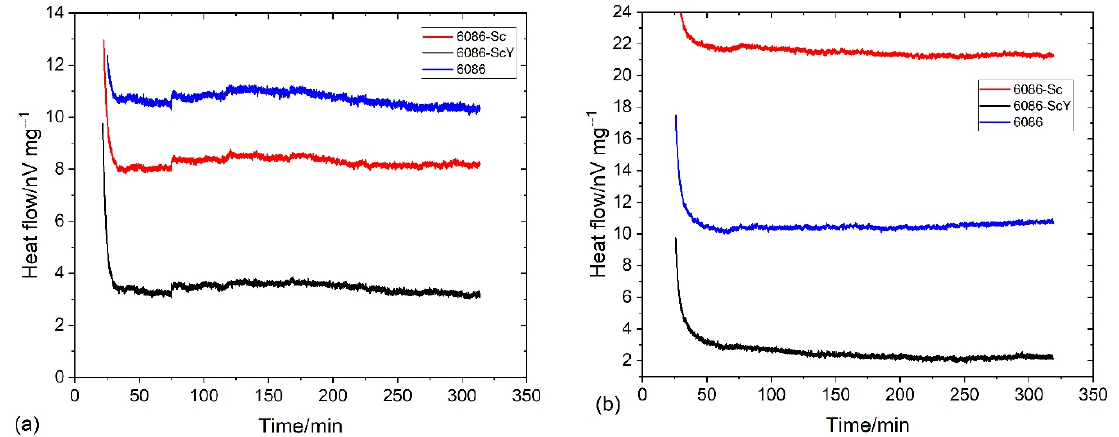
Figure 21. The results of DSC during isothermal annealing ( a ) at 300 ◦ C, ( b ) at 400 ◦